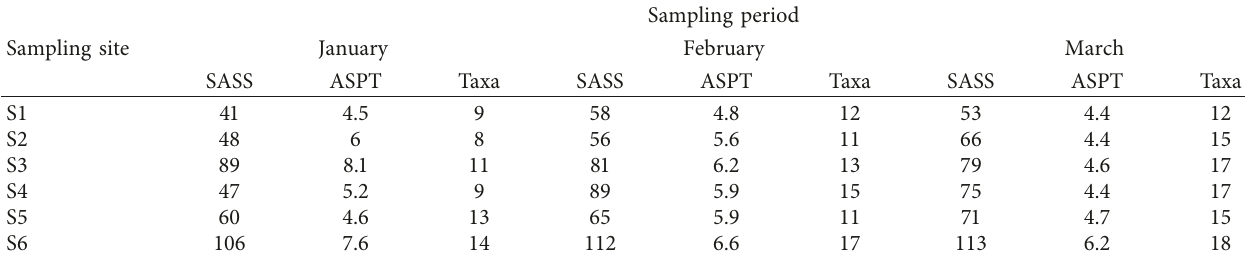
Table 4: SASS and ASPTindex values and number of taxa recorded at six sites in Sanyati basin, Lake Kariba for the period January to March